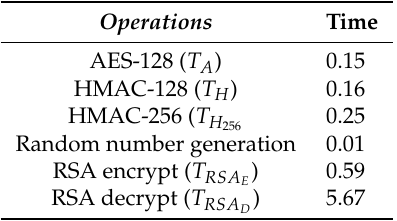
Table 7. The operation time of cryptography functions (ms).